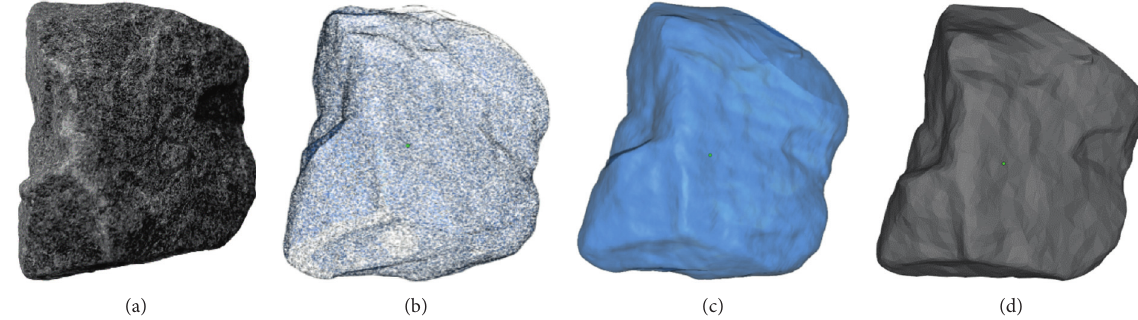
Figure 2: 3D reconstruction of the aggregate particle: (a) coarse aggregate particle; (b) 3D mesh; (c) fitted surface model; (d) solid